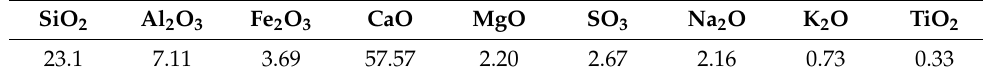
Table 1. Chemical compositions of cement (%).